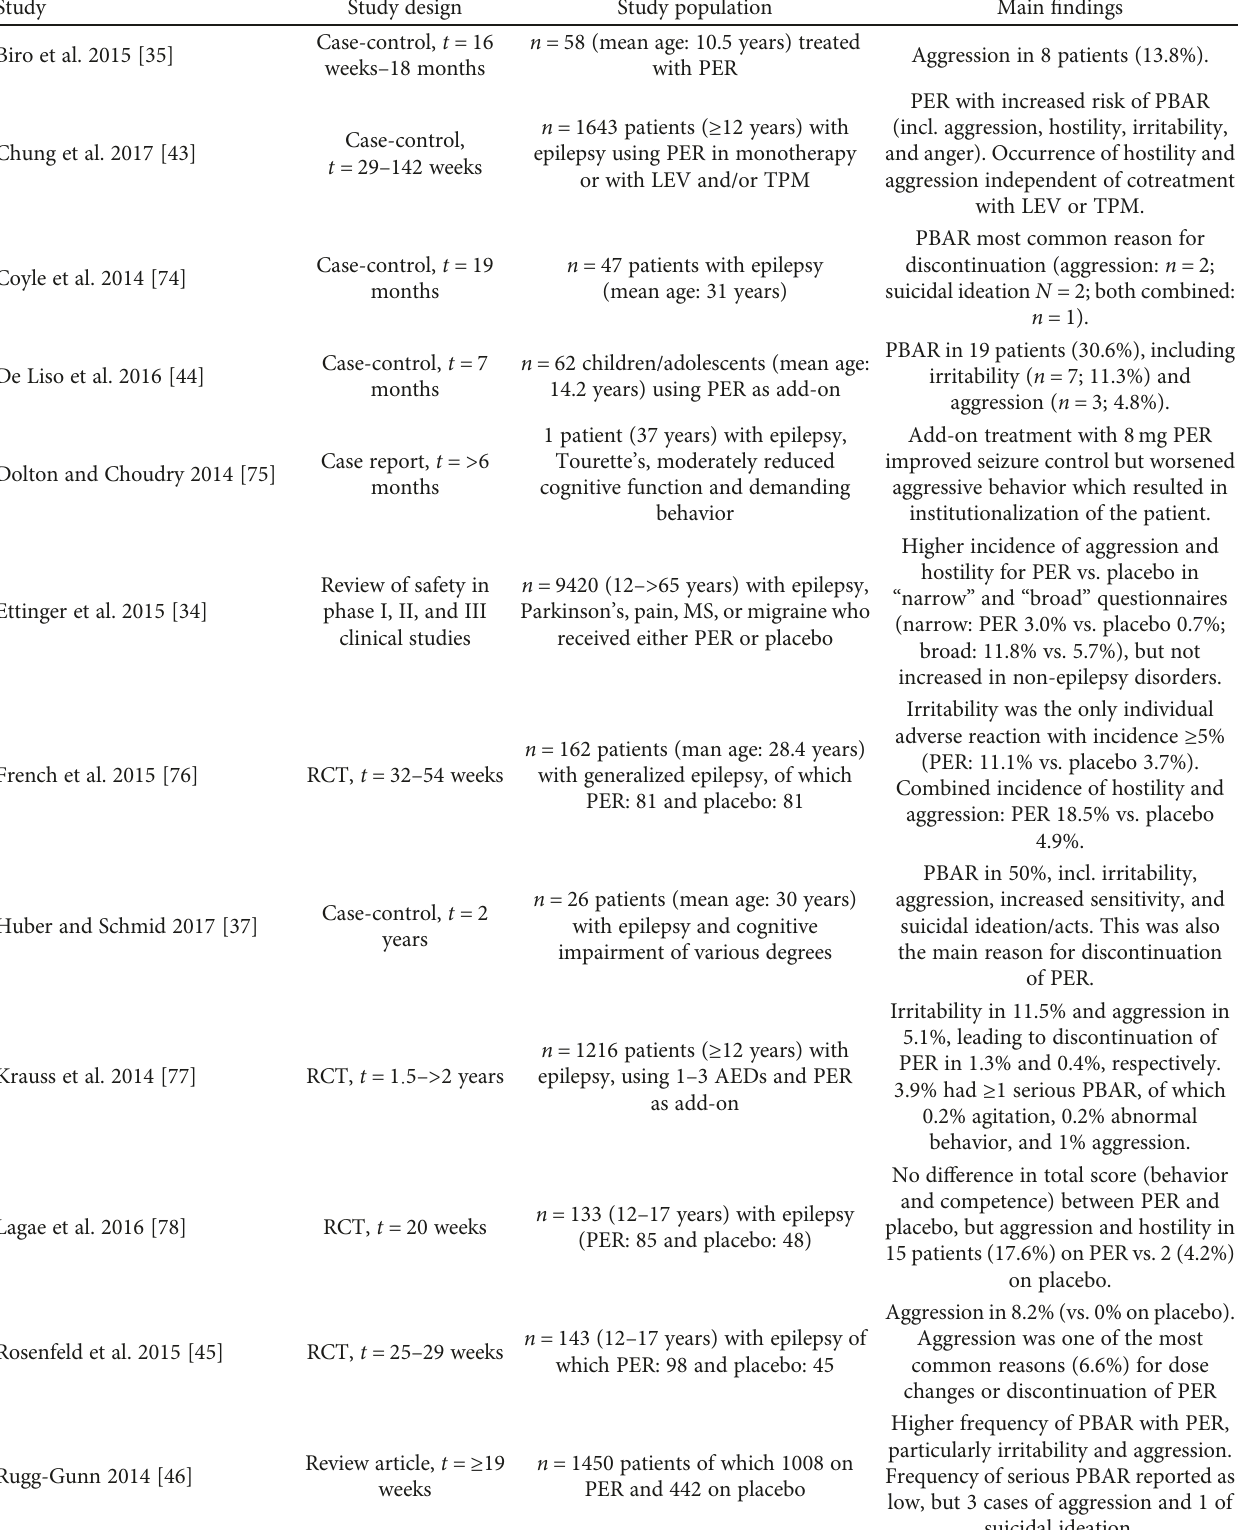
Table 3: Studies reporting psychiatric and behavioral adverse reactions to